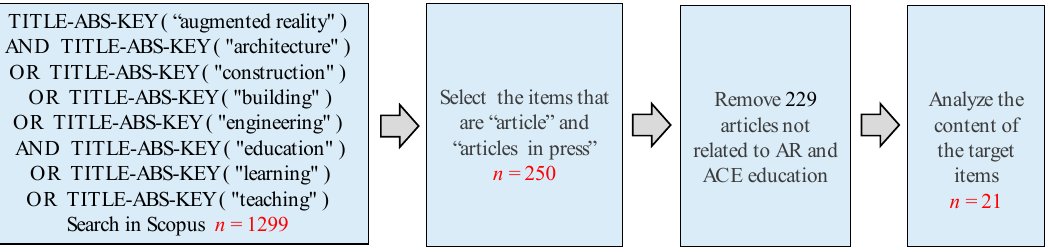
Figure 1. Scopus database searching steps.